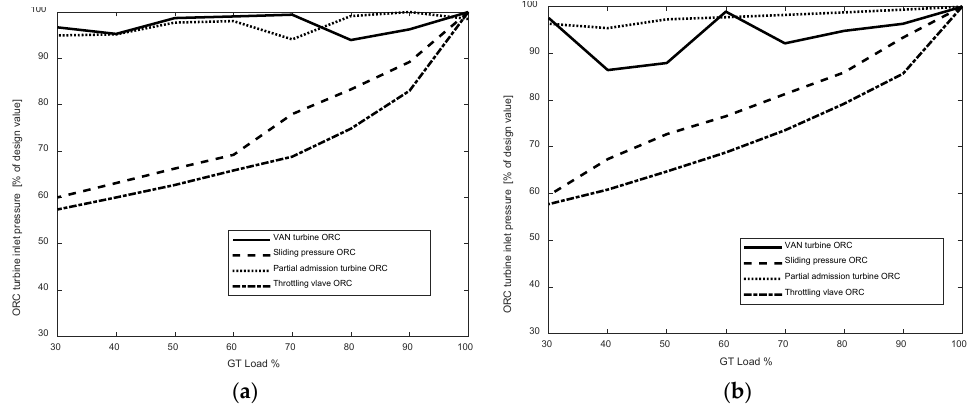
Figure 7. ORC turbine inlet pressure in off-design conditions: ( a ) case A; ( b ) case B.